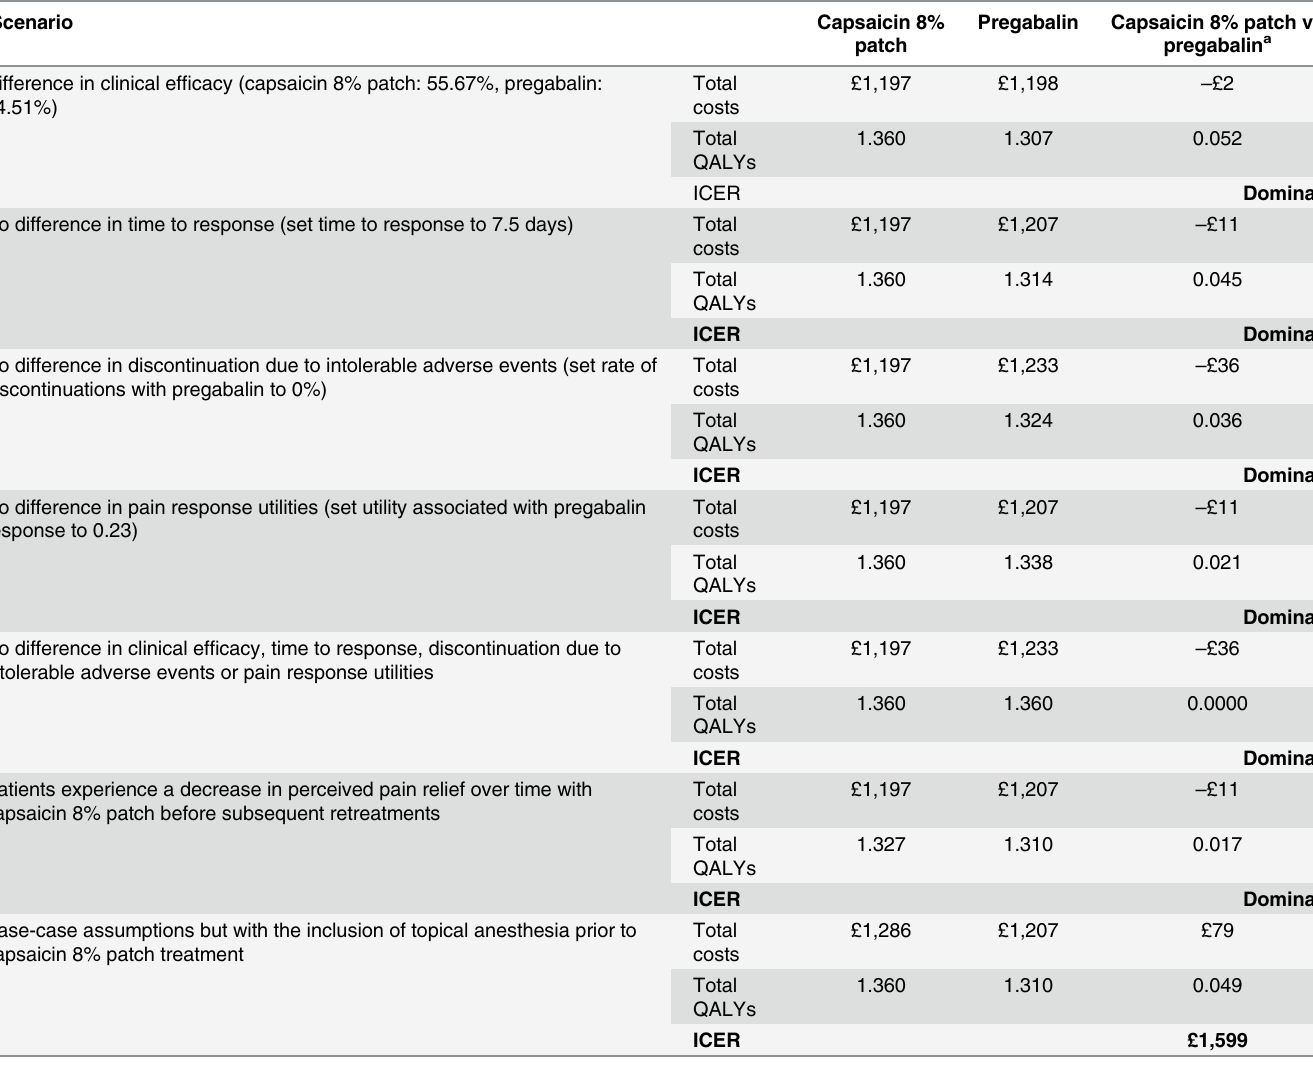
Table 4. Scenario